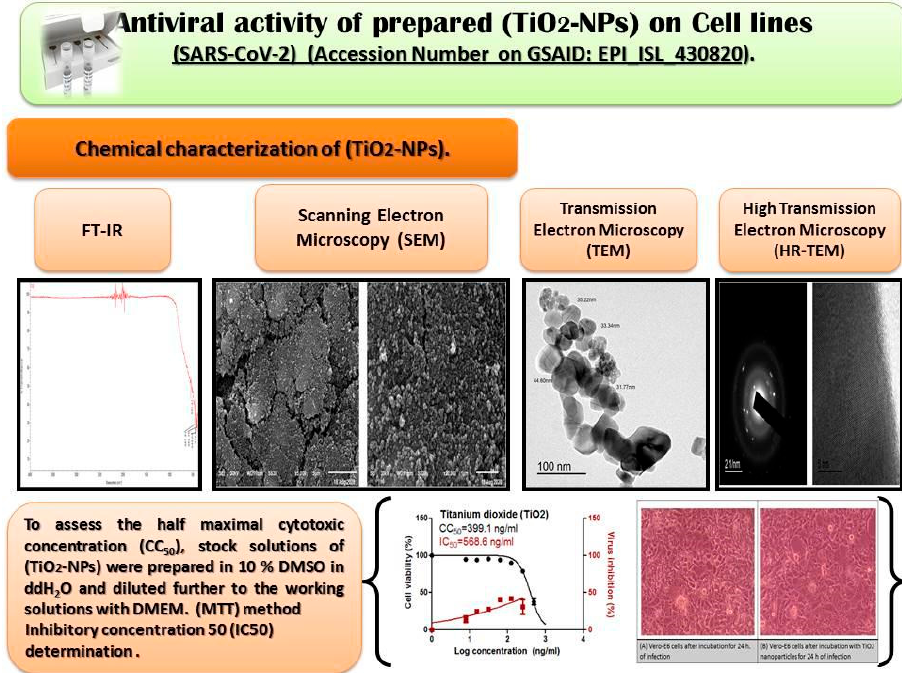
Scheme 1. Graphical abstract for the experimental protocol and summarization of the study.